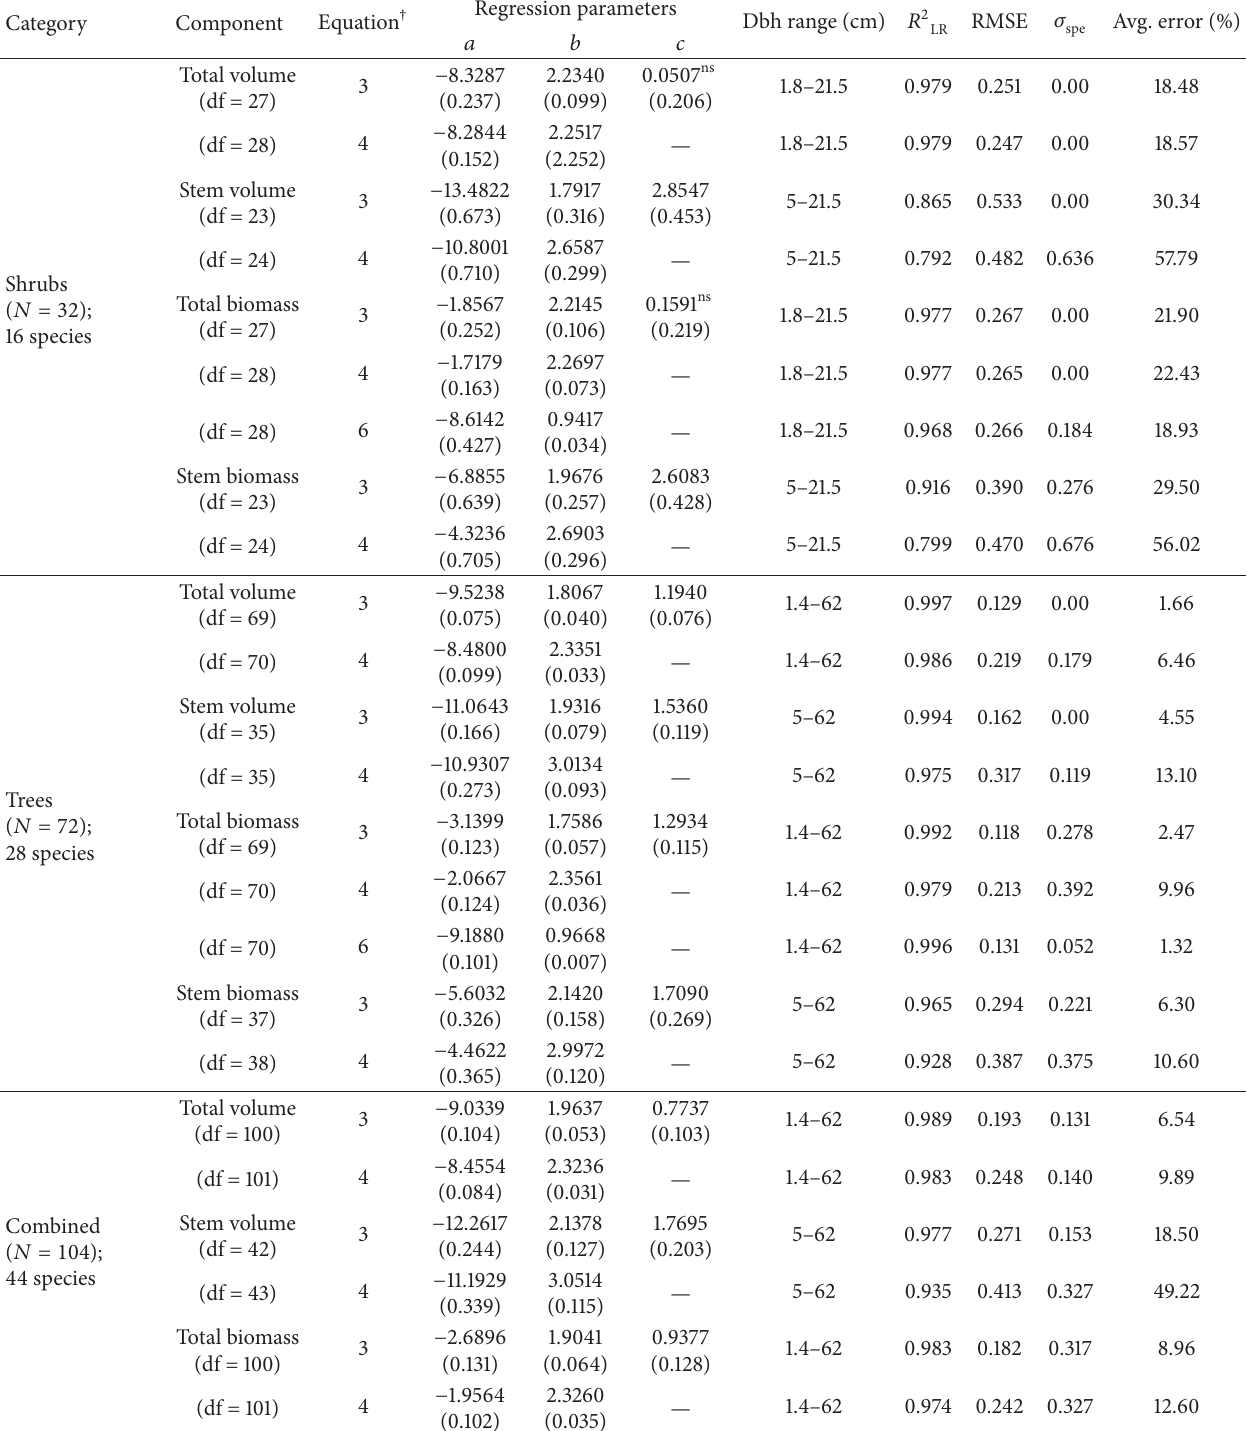
Table 2: Volume and biomass equations for estimating total aboveground and stem ( ≥ 5cm) volume and biomass of shrubs, trees, and woody plants in general (shrubs and trees) in Gangalamtumba Village Land Forest Reserve. A few estimates are not significantly different from zero ( 𝑃 > 0.05 ). These are marked